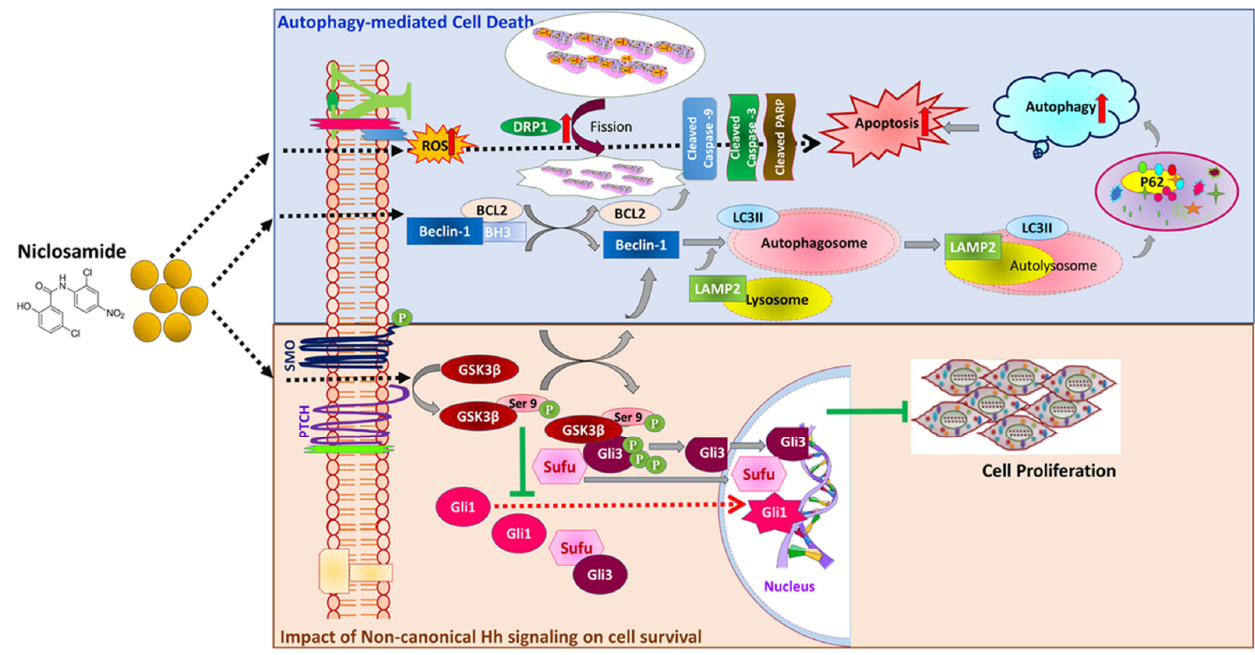
Figure 8. Graphical representation of overall niclosamide-mediated PC cell death mechanism(s) in pancreatic cancer: Our data demonstrated the potent anti-cancer effect of Nic in PC cells by inactivation of Gsk3 β by inhibitory phosphorylation of its Ser-9. Up regulation of p-Gsk3 β potentially modulates molecular signaling(s), including Hh/Gli cascade and mTORC1-dependent autophagy. Impact on non-canonical Hh signaling, the upregulation of Sufu, and nuclear accumulation of Gli3 with concurrent downregulation of Gli1 that inhibit Hh signaling and ultimately led to inhibition of PC cell proliferation/survival. Nic-induced cell death was associated with the involvement of mitochondrial stress-mediated apoptosis and mTORC1-dependent autophagy by inhibiting the interaction between Beclin-1 and BCl2 provides the cross regulatory mechanism of autophagy and apoptosis.